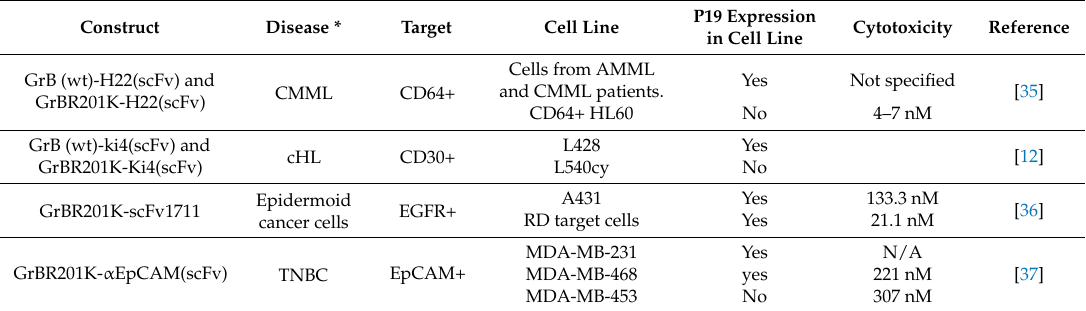
Table 1. Granzyme B based human Cytolytic Fusion Proteins (hCFPs) resistant to serpin B9 inhibition, targeting surface proteins expressed in various